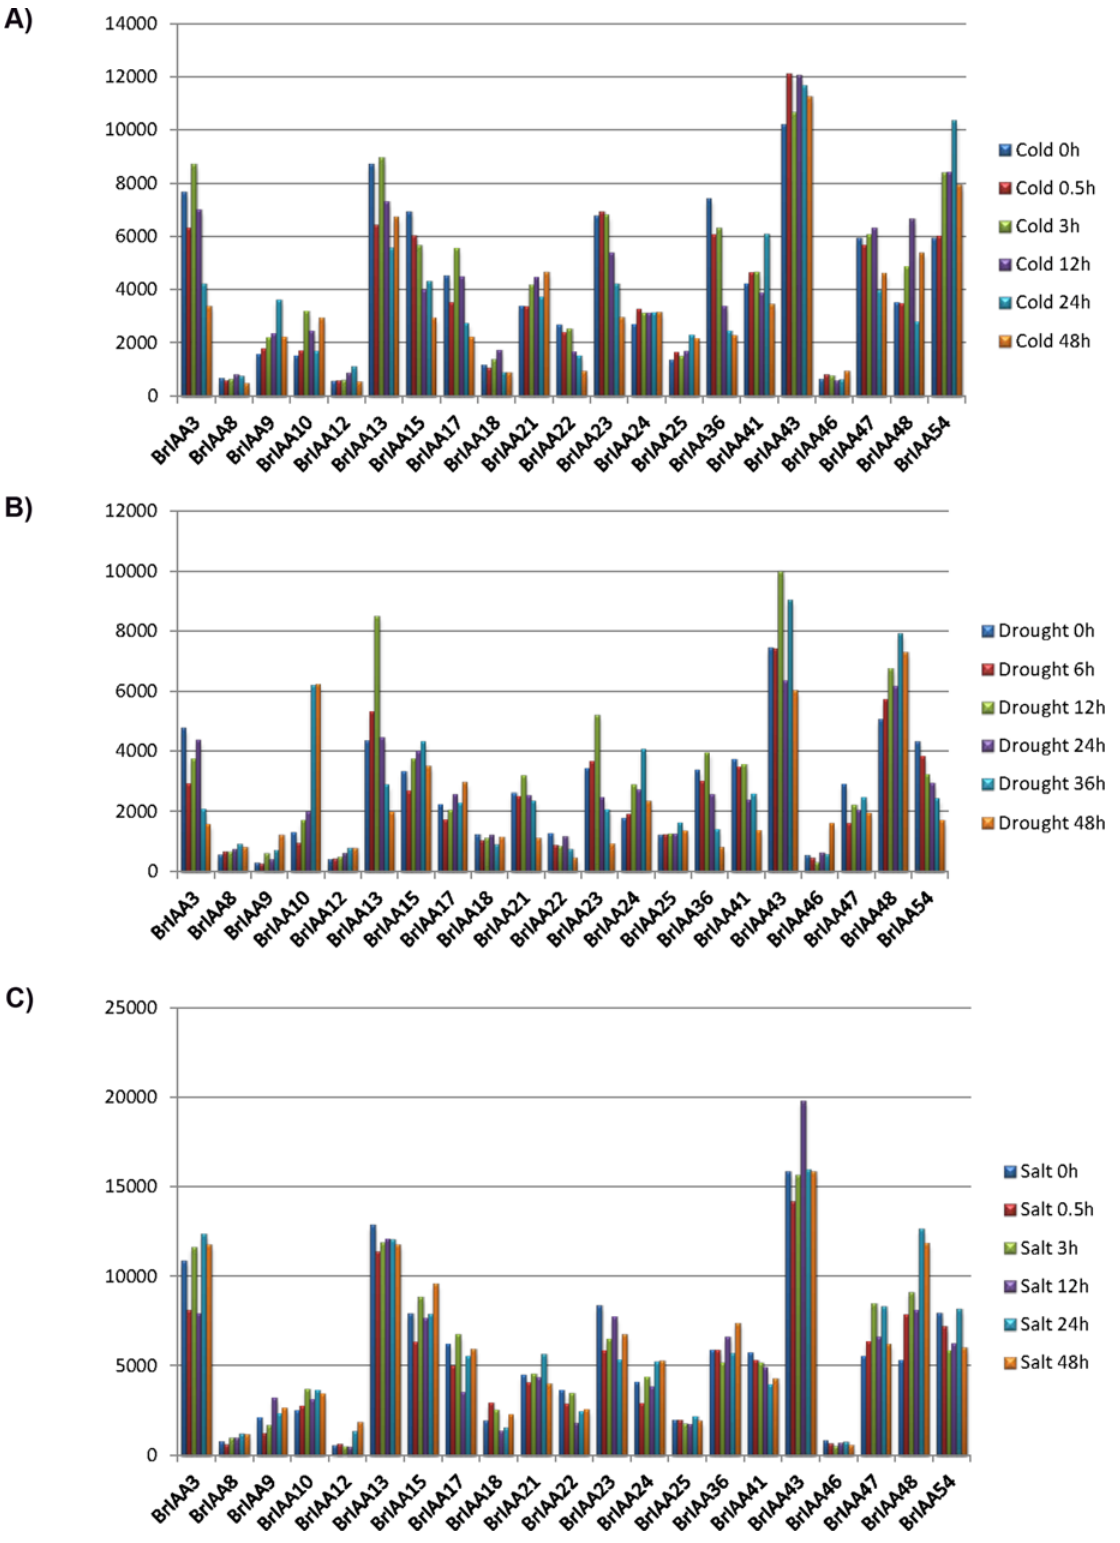
Fig 4. Stress response of BrIAA genes to cold, salt and drought treatments at various time points. Differentially expressed genes during A) cold B) drought C) salt treatments during various time. X axis represents the genes and Y axis represents the level of gene expression.